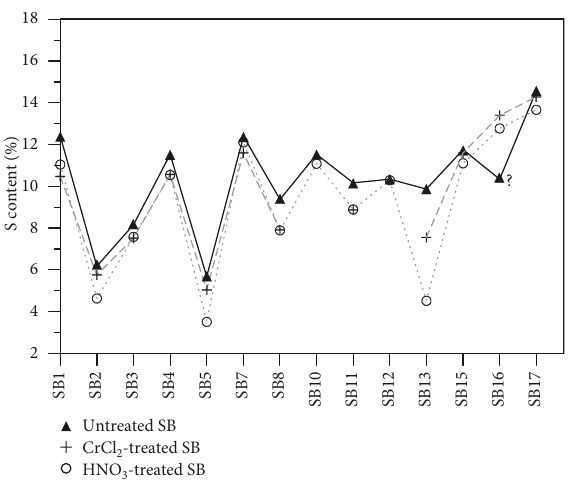
Figure 6: Variation in the sulfur contents of the untreated, CrCl -treated, and HNO -treated solid bitumen (SB) samples. 2 3